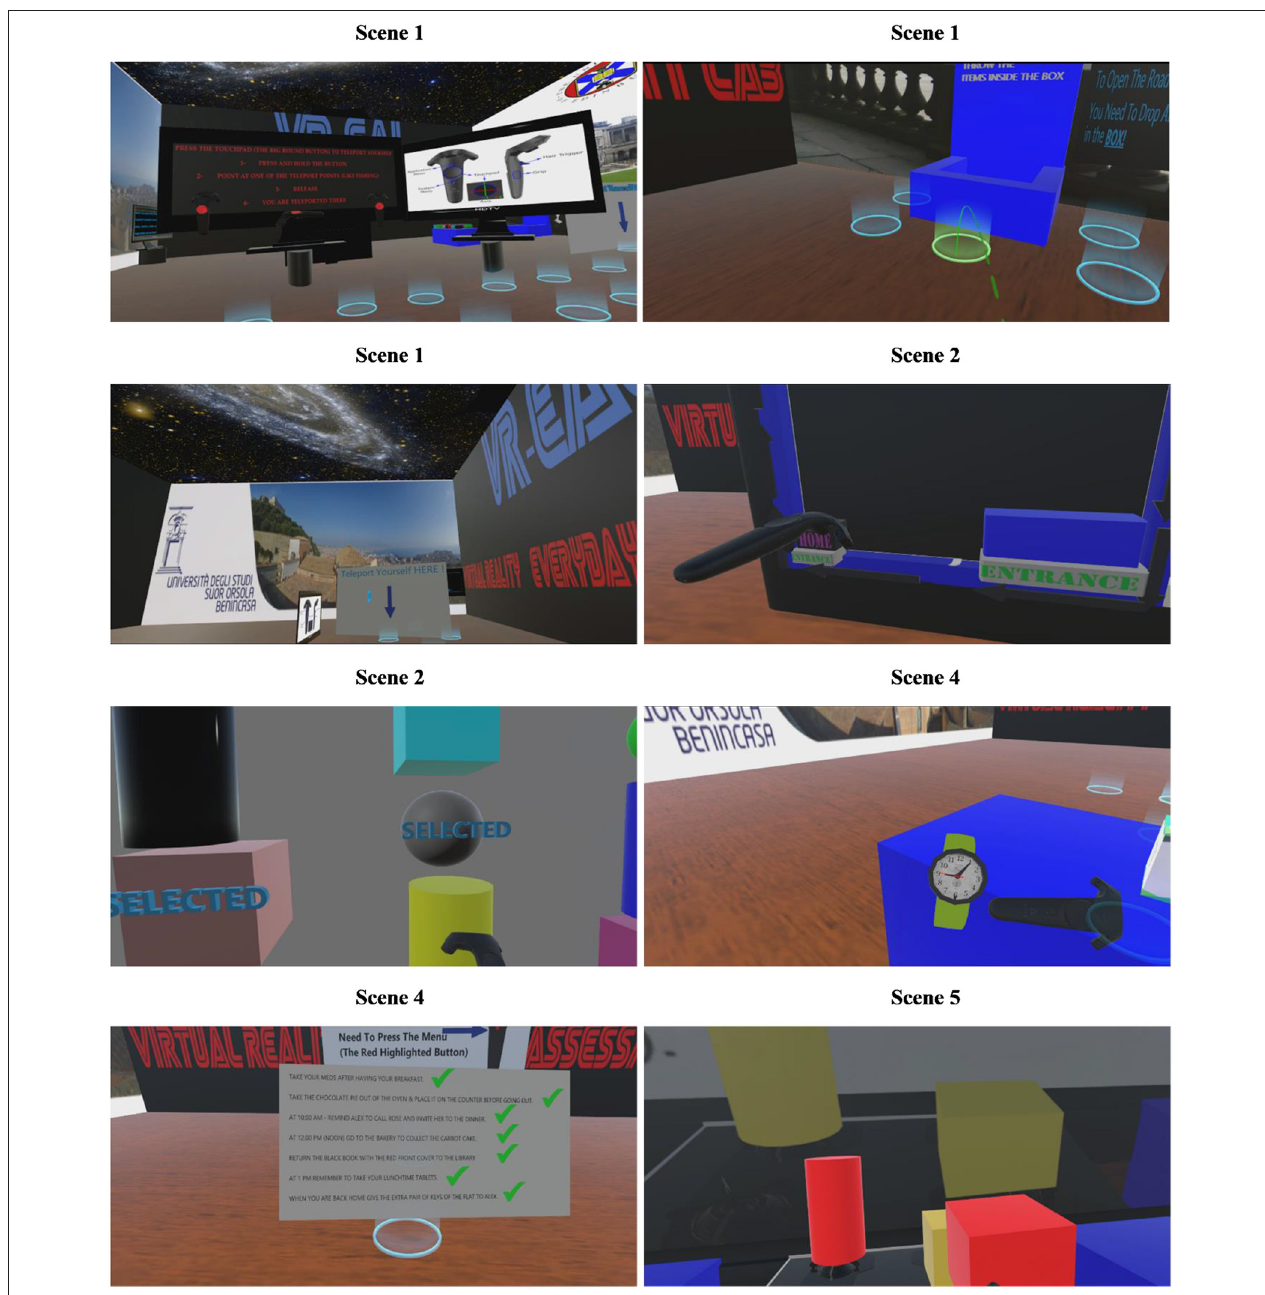
FIGURE 1 | VR-EAL tutorials: scenes